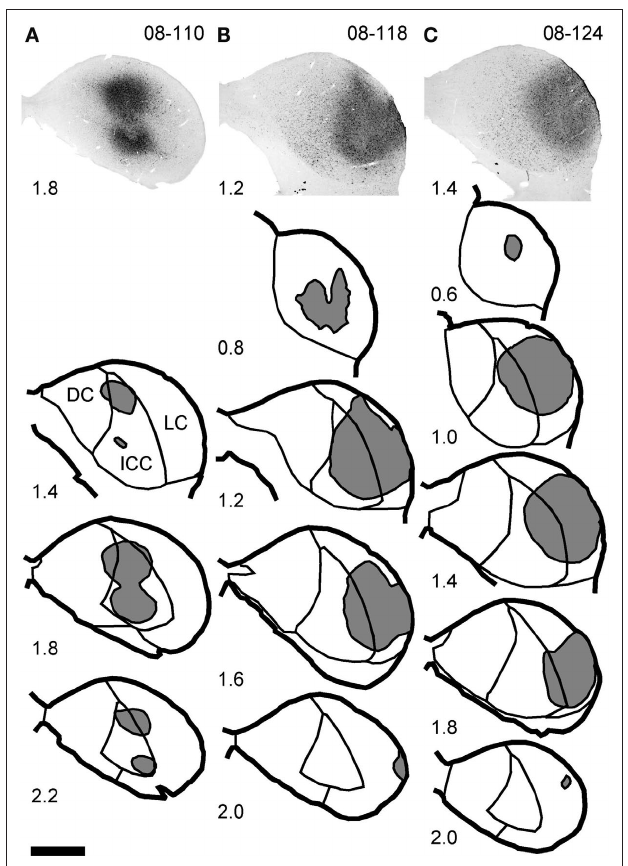
Figure 1 | injection sites of Fg. Top images show the center of the injection site in three animals processed for fluorescent ISH. Line drawings show the full extent of the injection sites (gray) at several rostro-caudal levels. In case 08-110 (A) , the injection is almost restricted to the central nucleus (ICC). In cases 08-118 (B) and 08-124 (C) , the injections are larger, and they cover both the lateral cortex (LC) and lateral part of the ICC. Numbers indicate the distance (in millimeters) from the section which contains the most rostral part of the ventral nucleus of the lateral lemniscus (VNLL). Note that in the case 08-110, two injections were made. Scale bar: 1